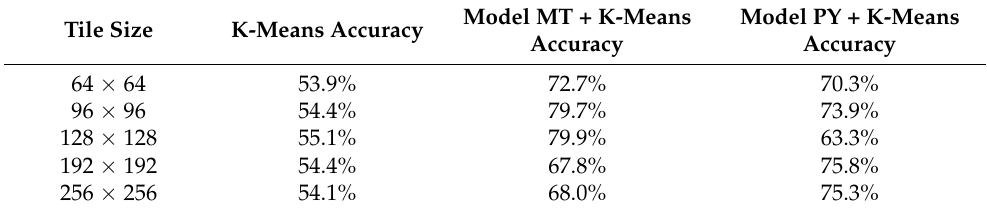
Table 7. Tile accuracies of the unsupervised learning methods for Top Pit.